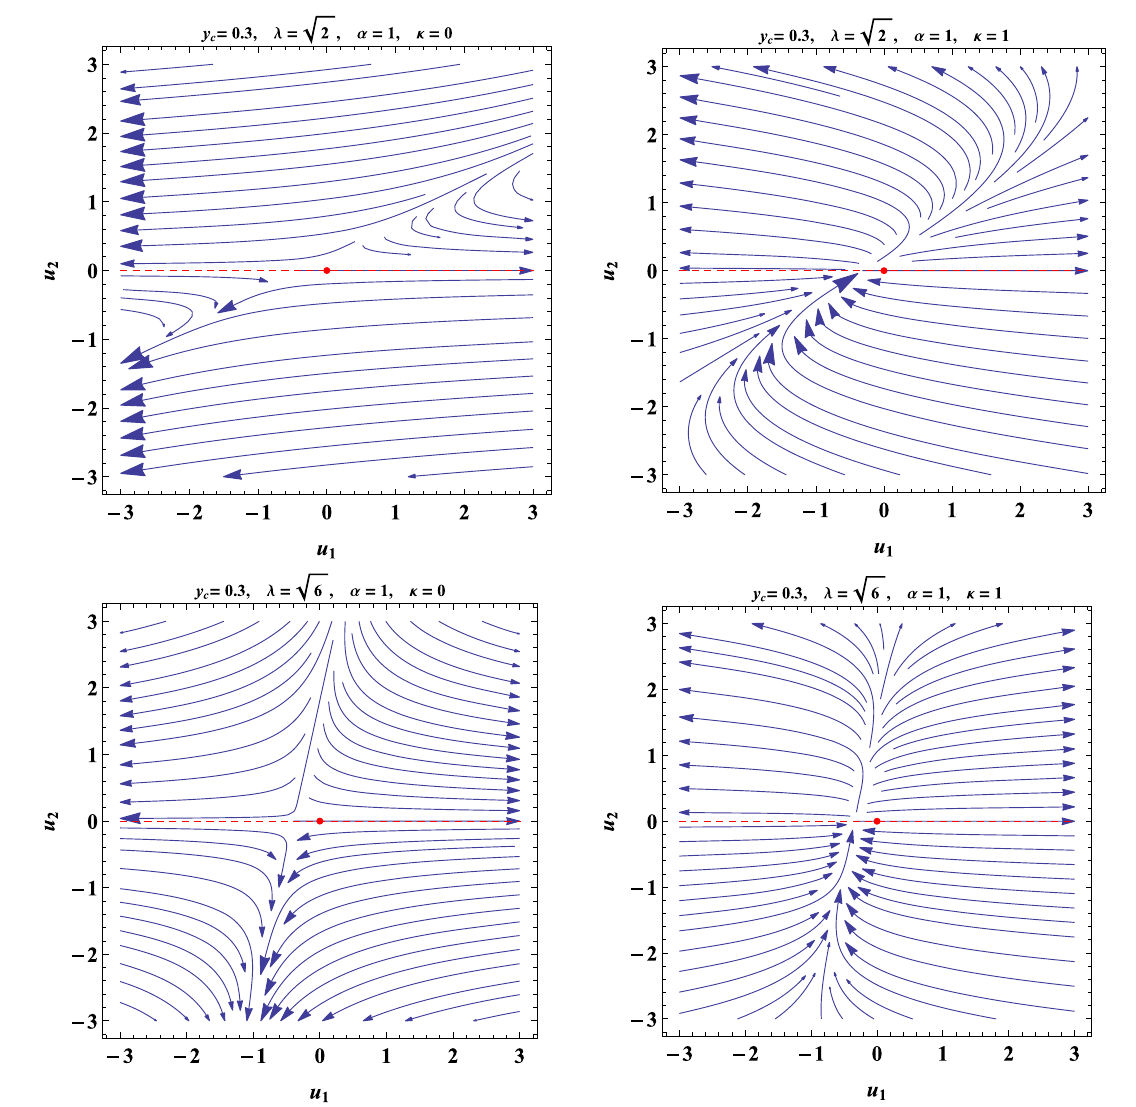
Fig. 2 Phase plot of system (42) for some values of the parameters showing that A (cid:4)